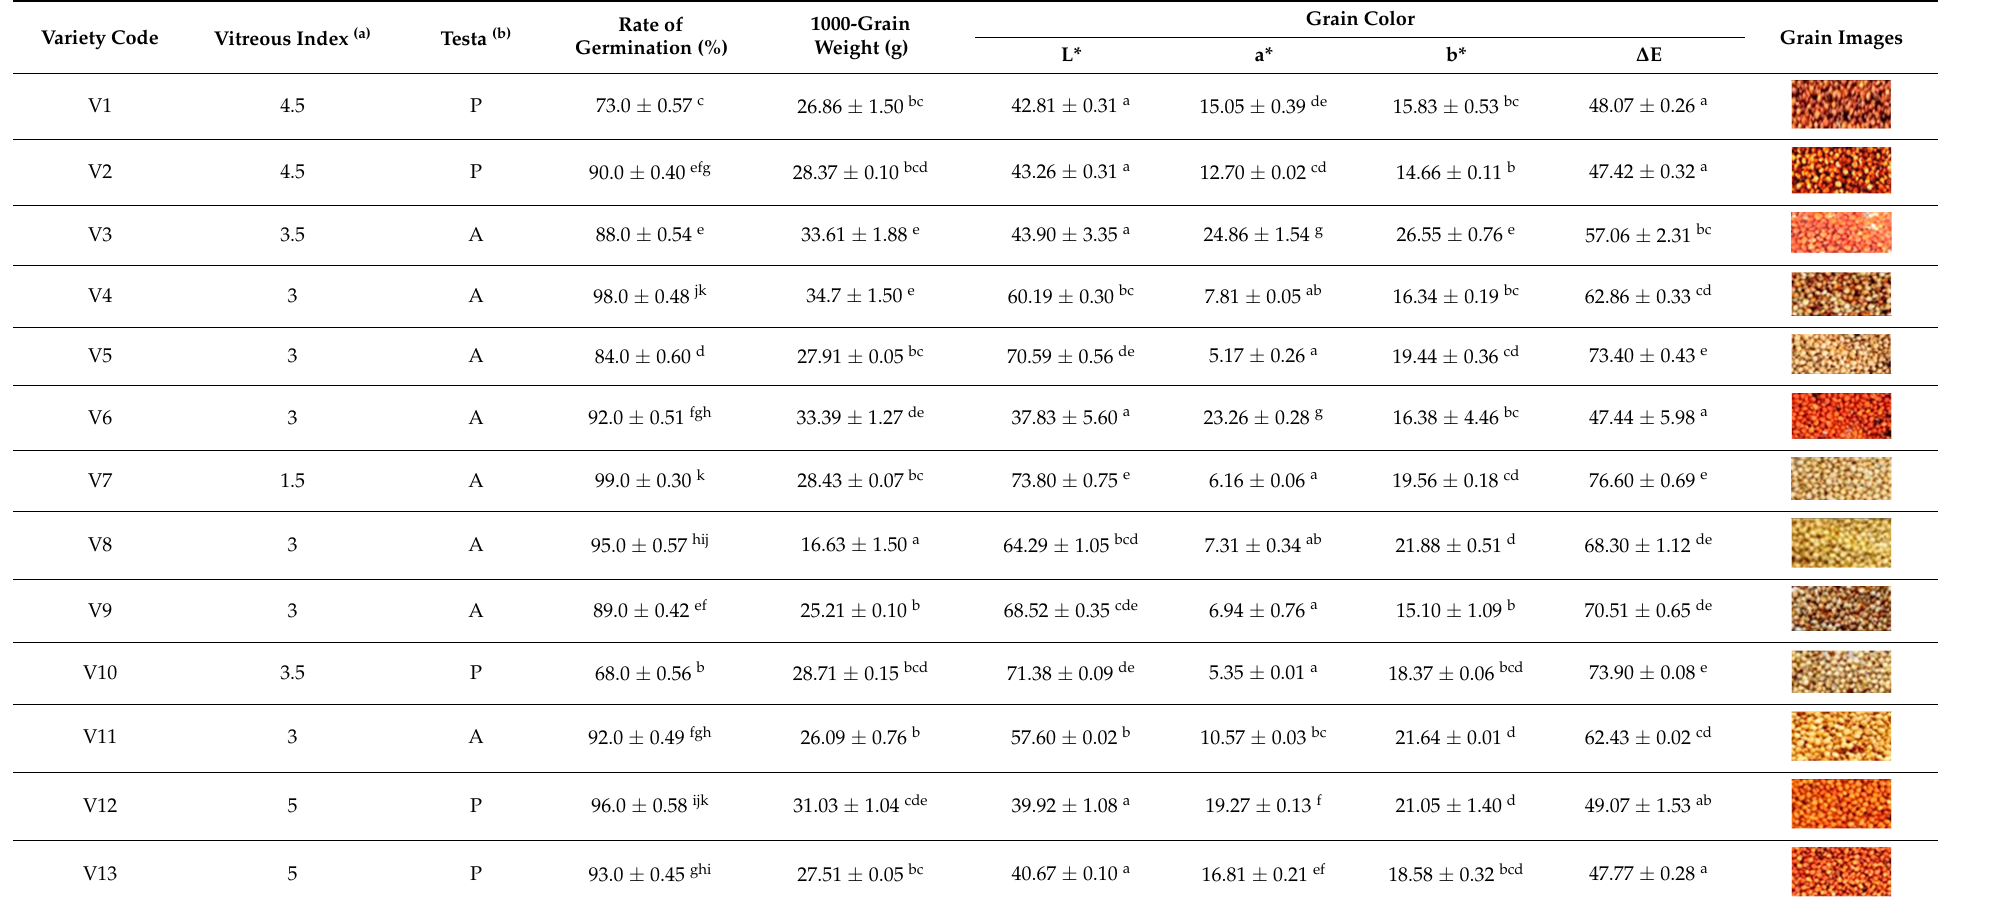
Table 2. Grain characteristics of studied